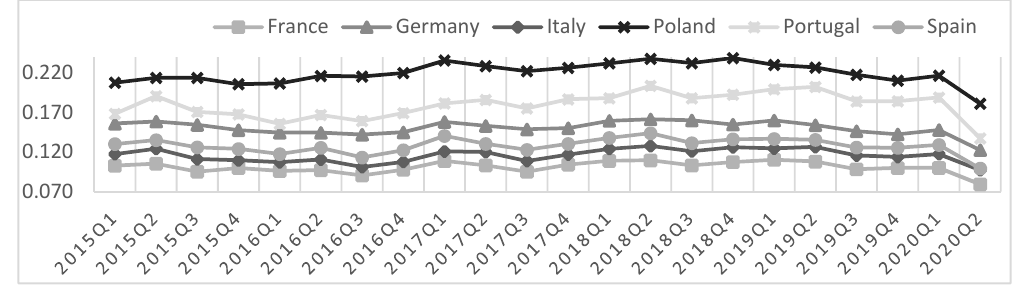
Figure 7. Import intensity coefficient of export, own work, source: Eurostat.